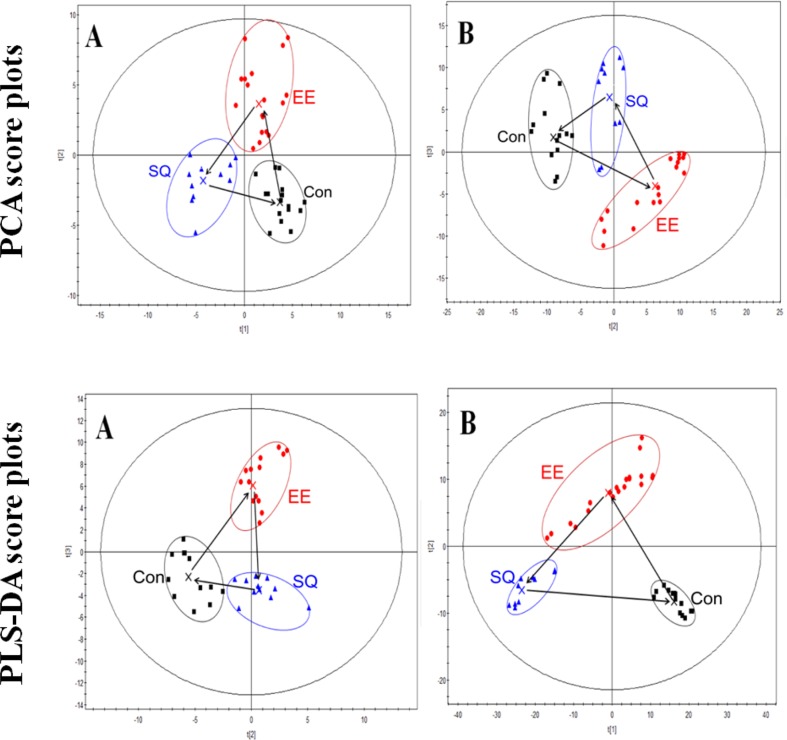
Principle component analysis (PCA) and partial least-squares discriminant analysis (PLS-DA) score plots of the serum data of the control, model, and treatment groups in the ESI positive-ion (A) and negative-ion (B) V modes based on UPLC/TOF-MS. Con, control group; EE, exhaustive exercise (swimming) smodel group; SQ, treatment group.